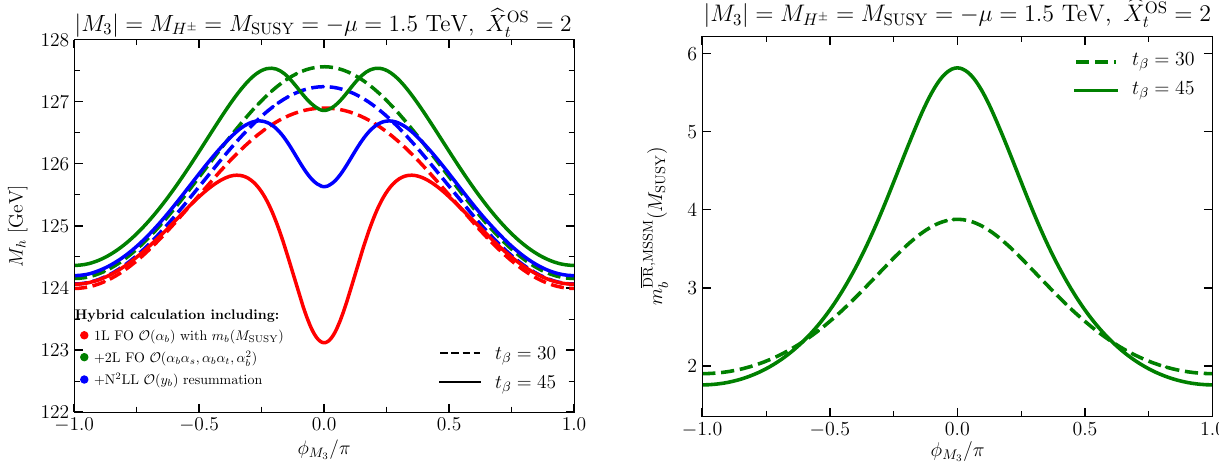
Fig. 8 Left: M h as a function of the phase of the gluino mass φ M dashed curves correspond to tan β = 30 and the solid curves to tan β = 45. Right: m DR , MSSM